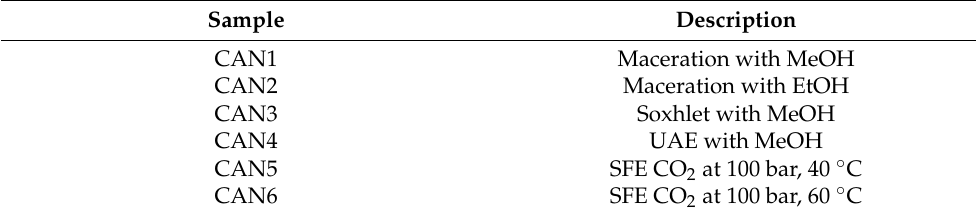
Table 5. Samples CAN1-CAN6 were prepared using different extraction methods.